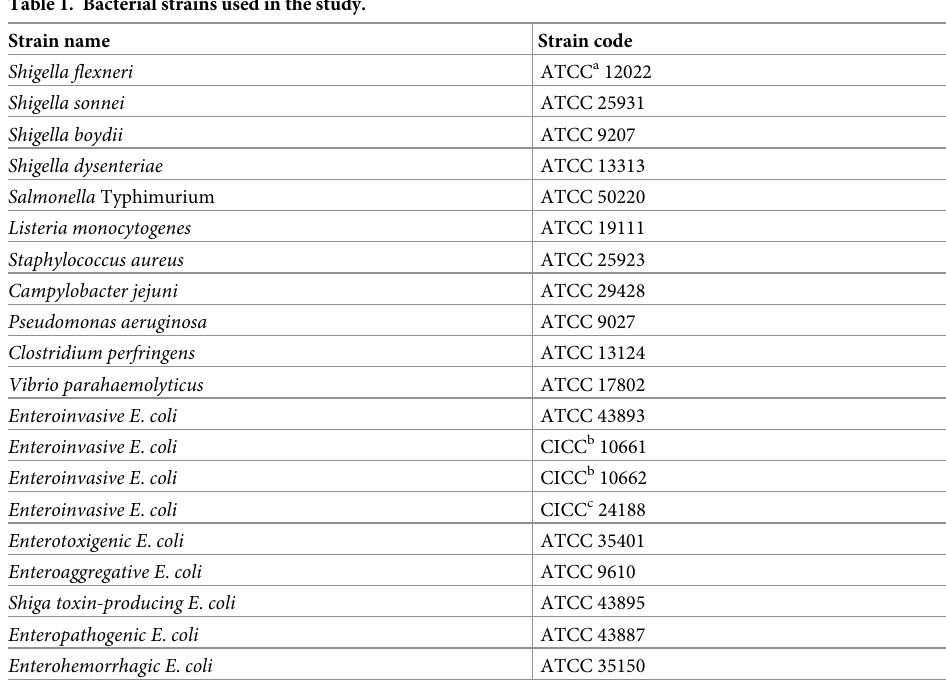
Table 1. Bacterial strains used in the